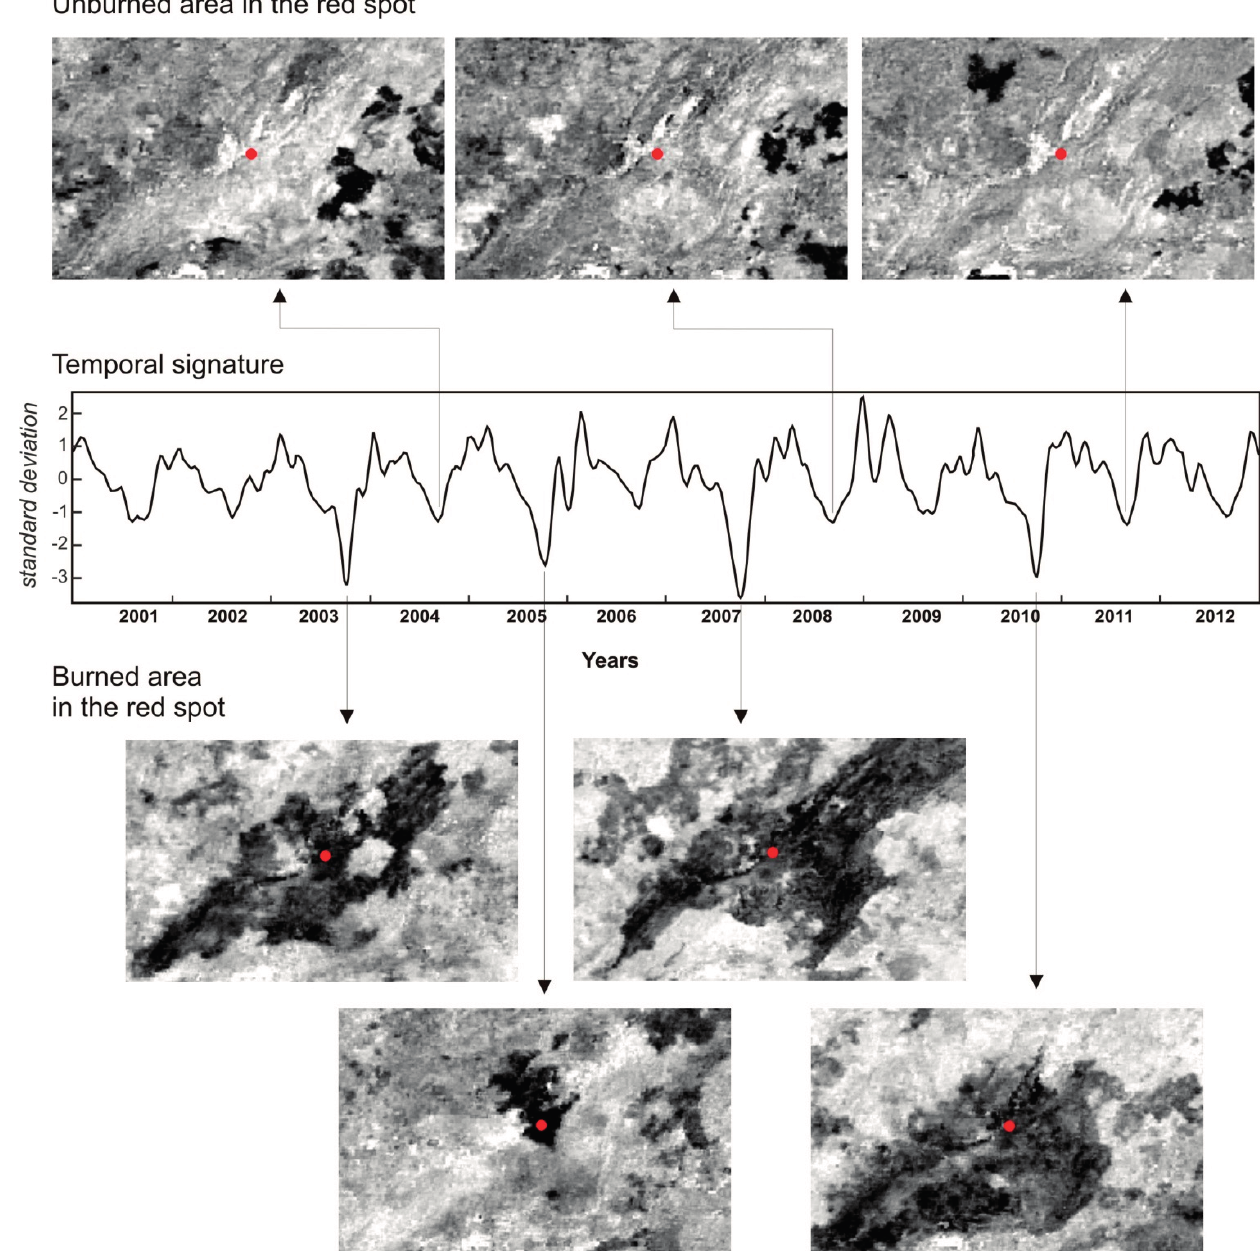
Figure 13. Temporal curve for the 12-year period emphasizing some standardized images. The red dot in the images demarcates the location of the time curve. The images in the upper part correspond to the unburned period. While the images at the bottom point out burned events, during the analyzed